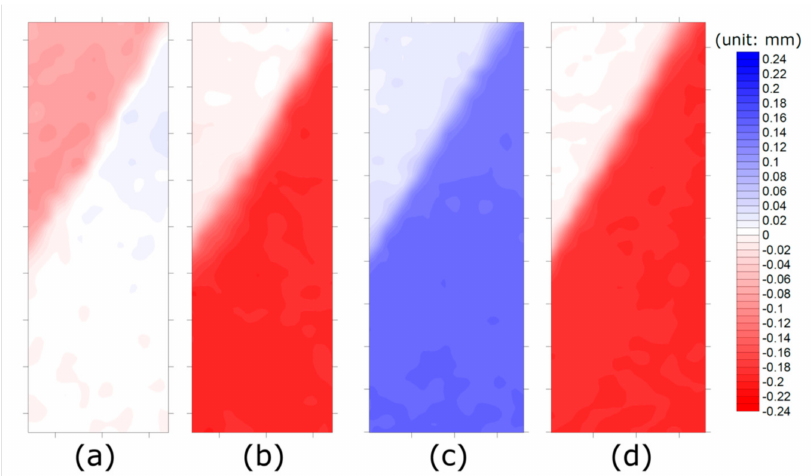
Figure 11. Displacement contours for the steady-state stage of the stress–strain behavior (5.5–5.75% strain): ( a ) NC1 horizontal; ( b ) NC1 vertical; ( c ) OC1 horizontal; and ( d ) OC1 vertical.